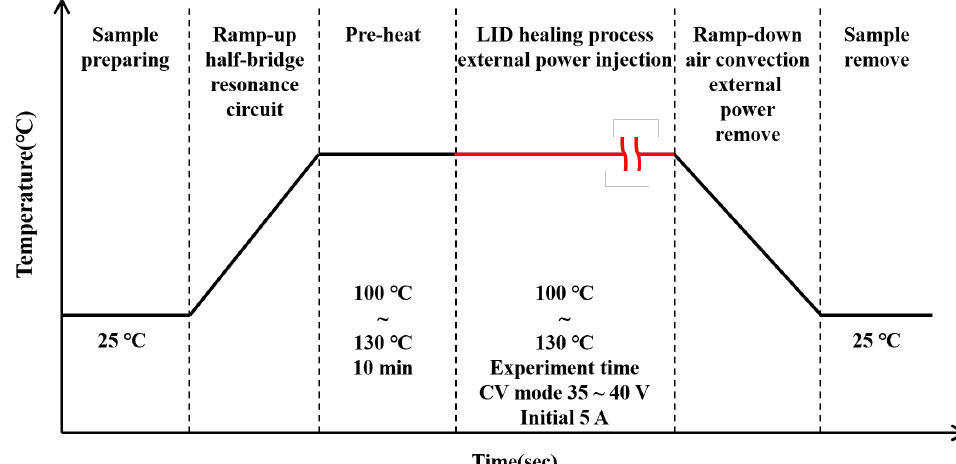
Figure 3. Experimental procedure used to treat LID in a p-PERC solar module. CV: constant